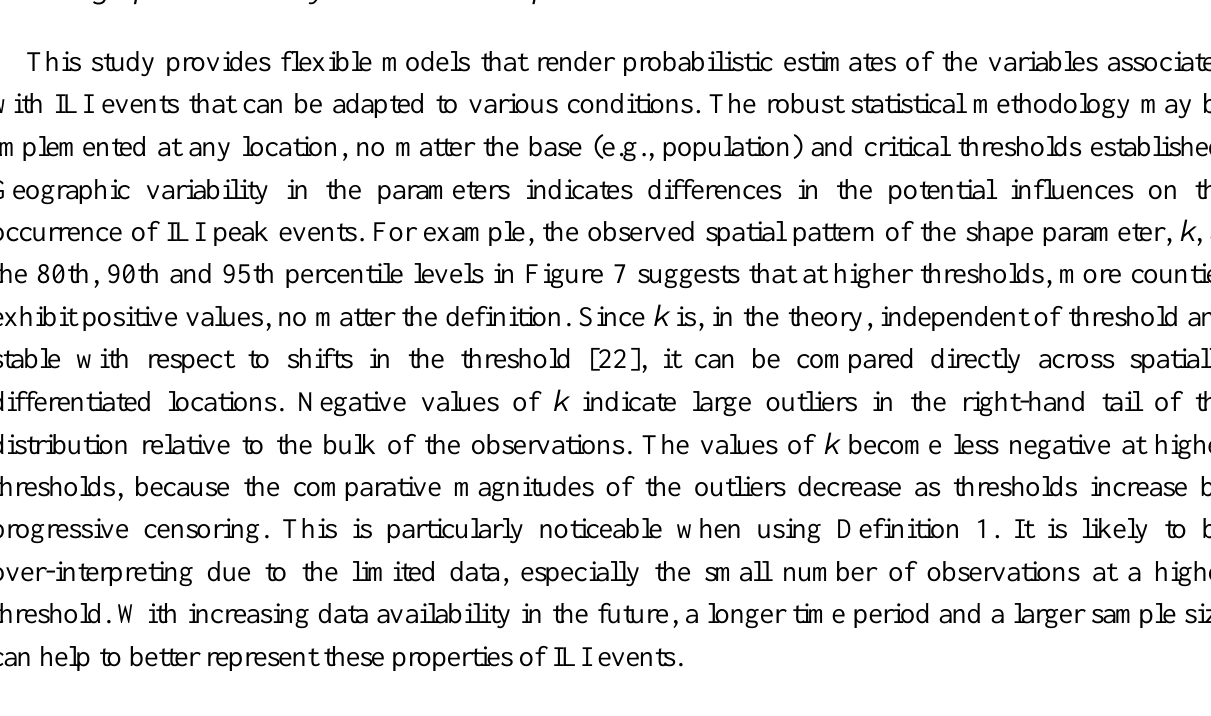
Figure 7. The observed spatial distributions of the parameter, k , values at three thresholds based on two definitions. ( a ) Definition 1, threshold 80%- k. ( b ) Definition 1, threshold 90%- k. ( c ) Definition 1, threshold 95%- k. ( d ) Definition 2, threshold 80%- k. ( e ) Definition 2, threshold 90%- k. ( f ) Definition 2, threshold 95%- k